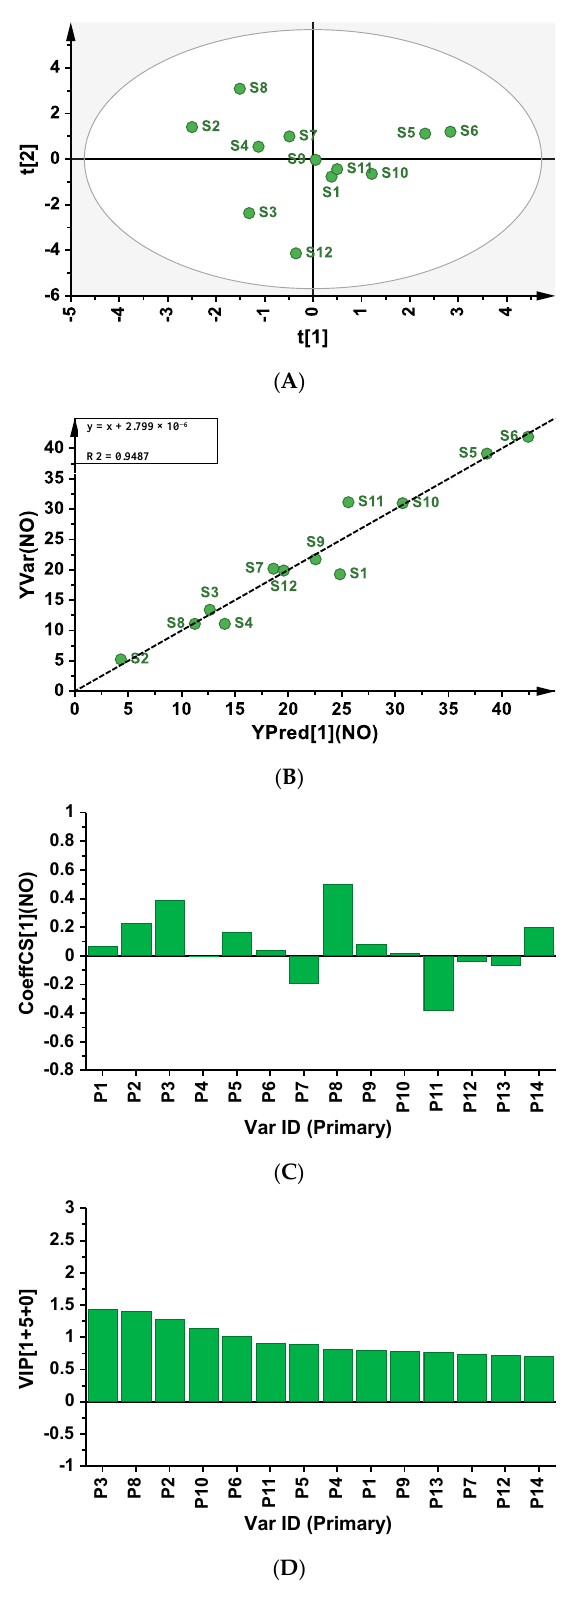
Figure 6. The correlation analysis of the PMP–HPLC fingerprint and immune activity through partial least-squares regression model. ( A ) The scatter plot scores of principle components; ( B ) The regression model between experimental and predicted NO values. ( C ) The coefficients plot; ( D ) The variable importance plot.